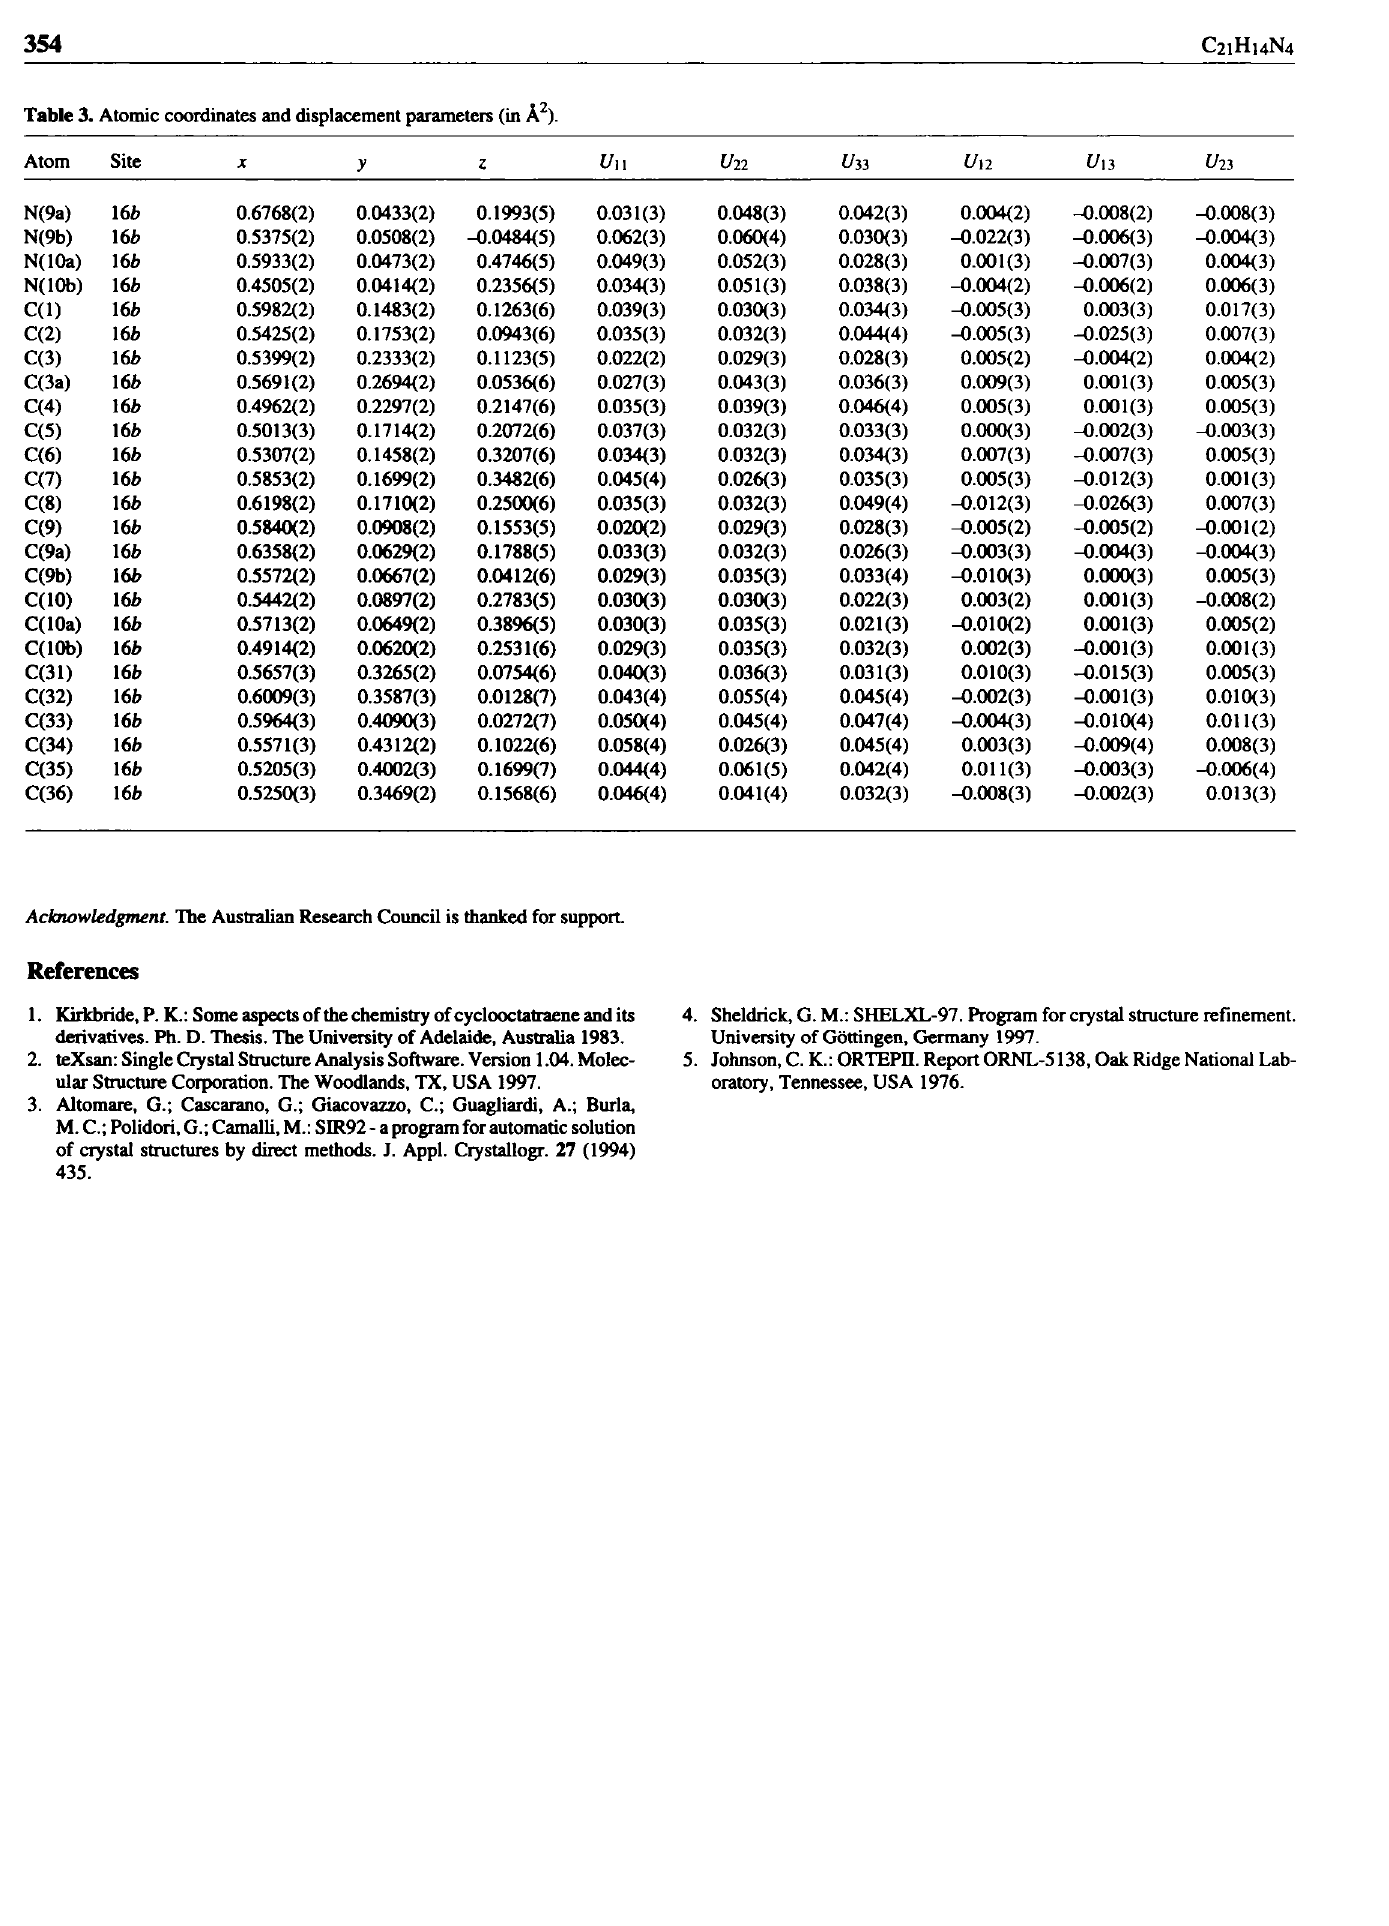
Table 3. Atomic coordinates and displacement parameters (in Ä 2